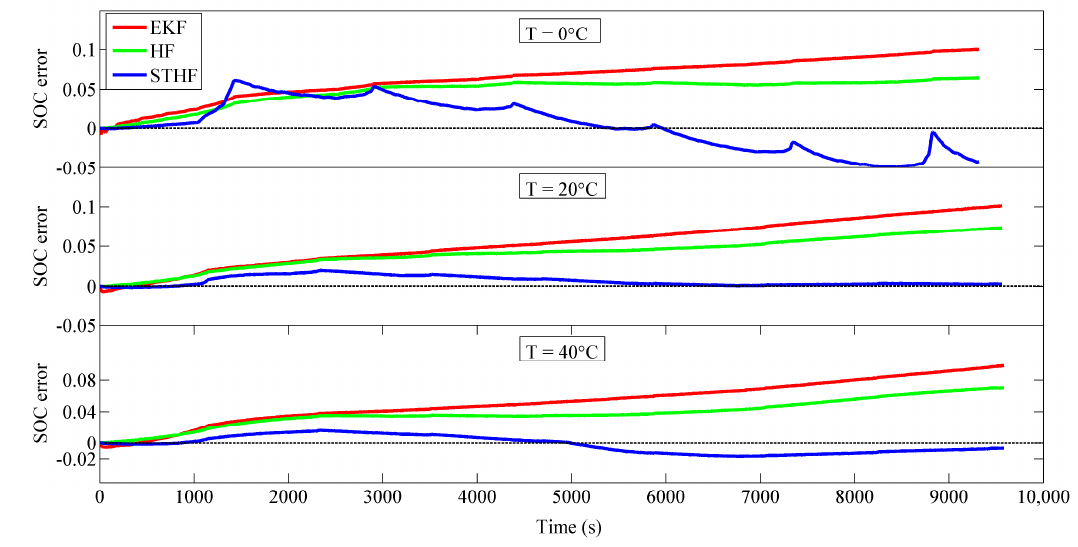
Figure 11. Estimation errors of STHF, HF, and EKF with 0.1 A current-biased noises.